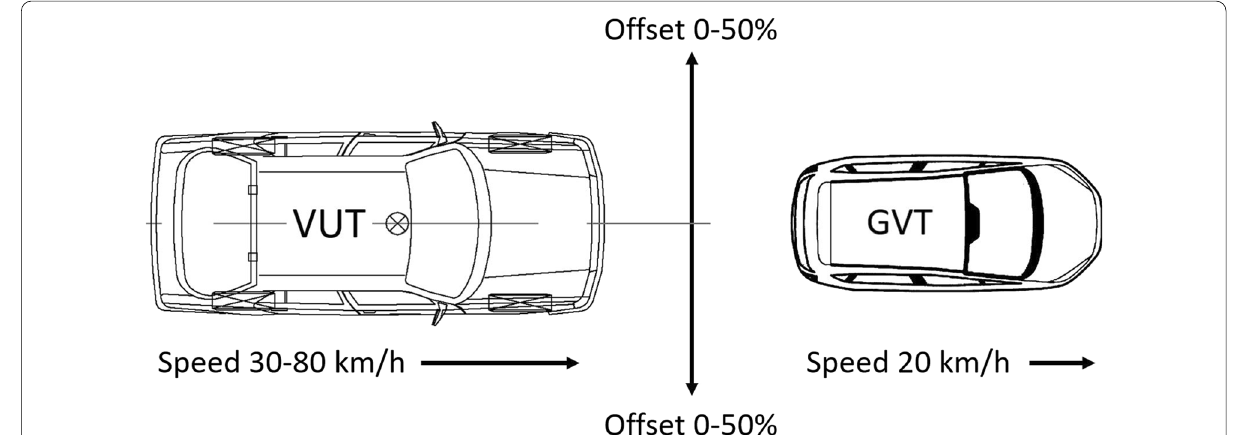
Fig. 9 Scheme of a EuroNCAP CCRm test for an Inter-Urban AEB